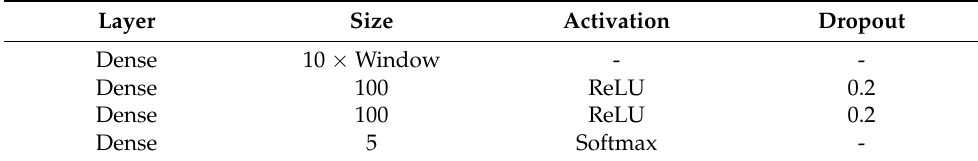
Table 5. Employed MLP